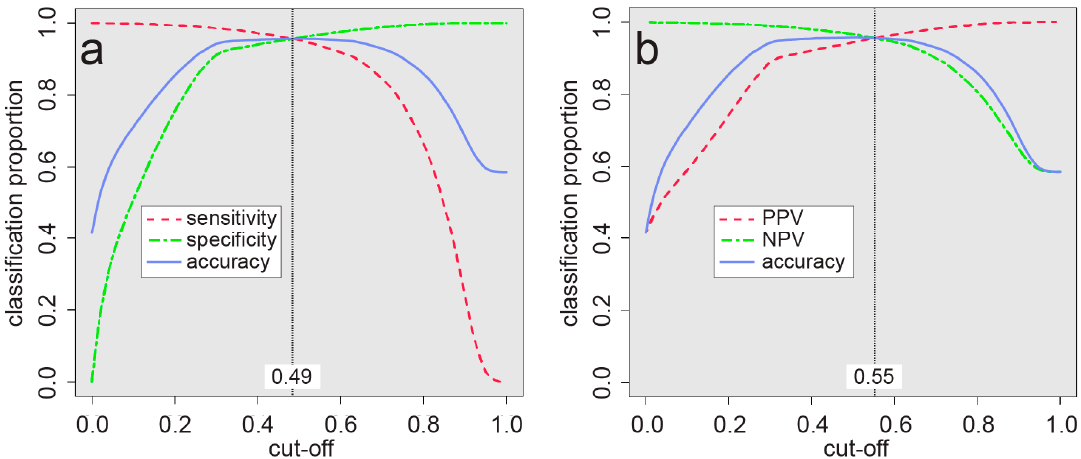
Figure 5. Analyses of model performance using full modeling dataset. ( a ) Sensitivity and specificity were found to be equivalent at a probability cutoff of 0.49 with a corresponding accuracy of 96%. ( b ) Positive predictive value (PPV) and negative predictive value (NPV) were found to be equivalent at a probability cutoff of 0.55 also with a corresponding accuracy of 96%. Table 4. Area and population potentially exposed to arsenic concentrations greater than 10 µg/L by state/territory. Based on probabilities in Figure 2a exceeding 0.49 and 0.55 along with the rates [64] of household groundwater use in rural and urban areas. See text for limitations.